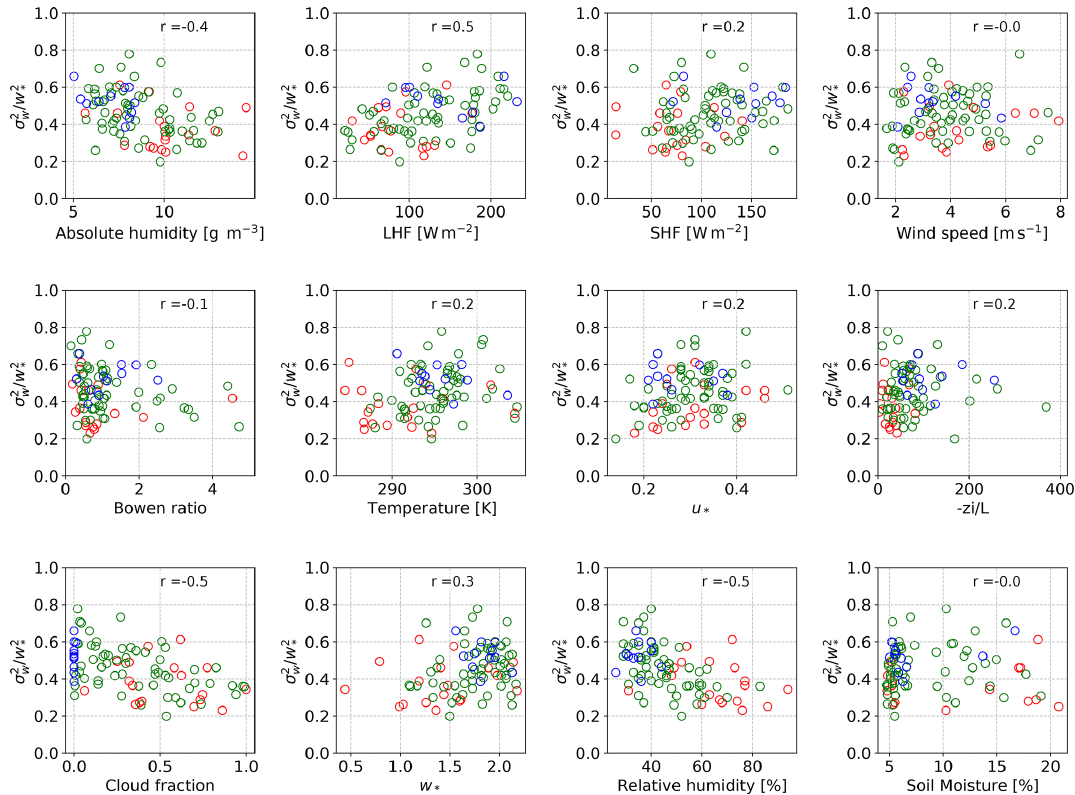
Figure 9. Scatter plots of the daily maximum values of σ 2 w /w 2 ∗ below 0.6 z i and the typical meteorological parameters describing the state of the atmospheric boundary layer. The blue dots represent the data on clear-sky days, green dots represent the data on cloud-topped days and red dots represent the data on rainy days.